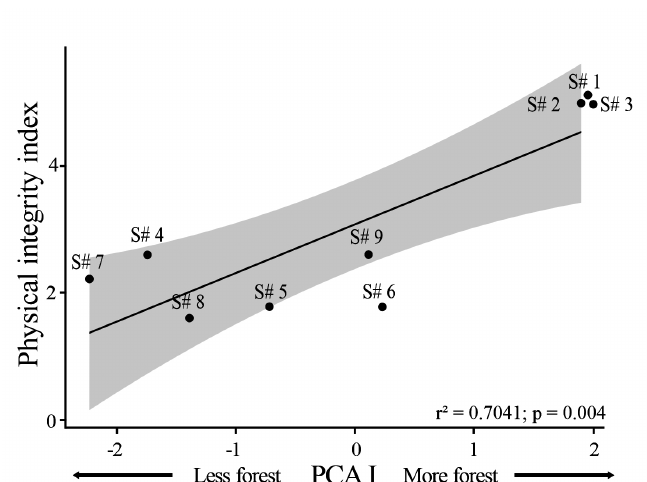
FIGURE 4 | Relationship between forest cover and the physical integrity index of streams located in the Tanguro Farm, Municipality of Querência, state of Mato Grosso. Forest cover is represented by the Axis I of the PCA performed with land use variables obtained from a 60 m buffer. Sites 1, 2 and 3 overlapped, and were rearranged for better visualization. Sgrid: Site.